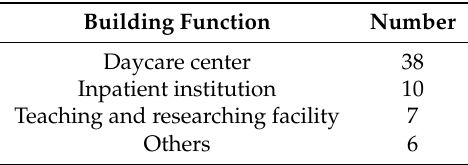
Table 1. The distribution of the building functions.